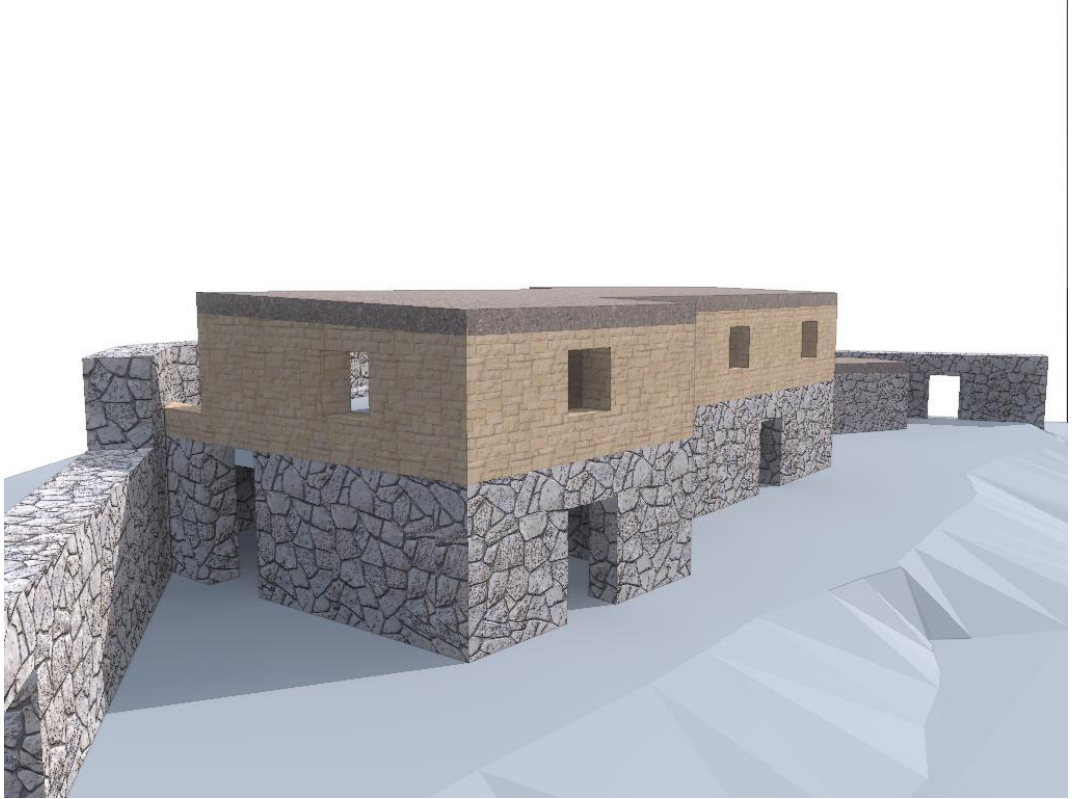
Figure 10. Agios Antonios Chomatas Site 9: ideal 3D reconstruction of the